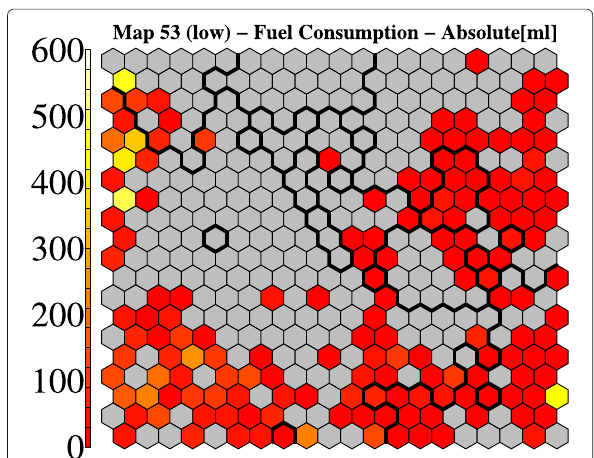
Fig. 15 Manoeuvre 78. Line plot of the variables in the codebook vector of node